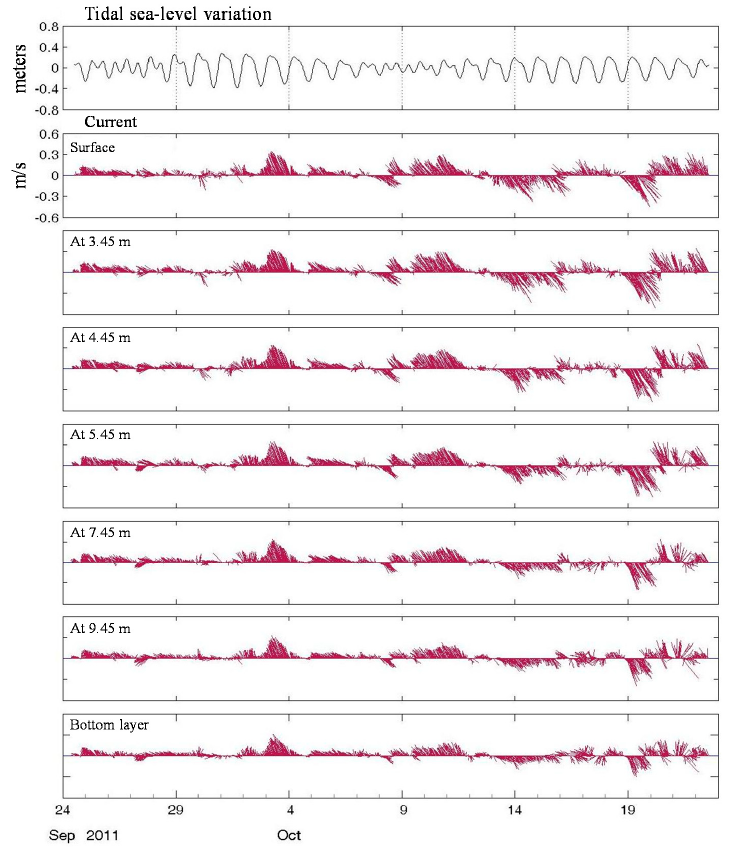
Figure 5. Tidal variation and current velocity measured with ADCP.